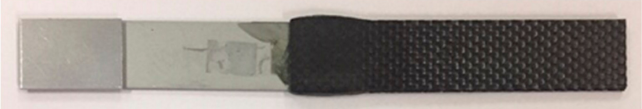
Figure 3. Fabricated specimen for shear lap adhesion